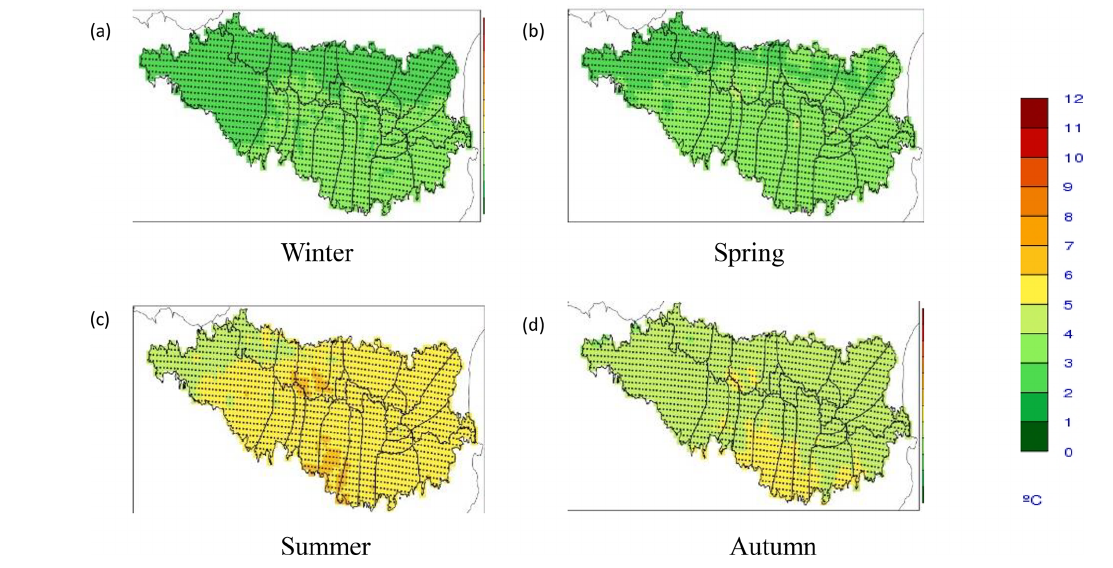
Figure 6. The same as Fig. 4 but for minimum temperature.